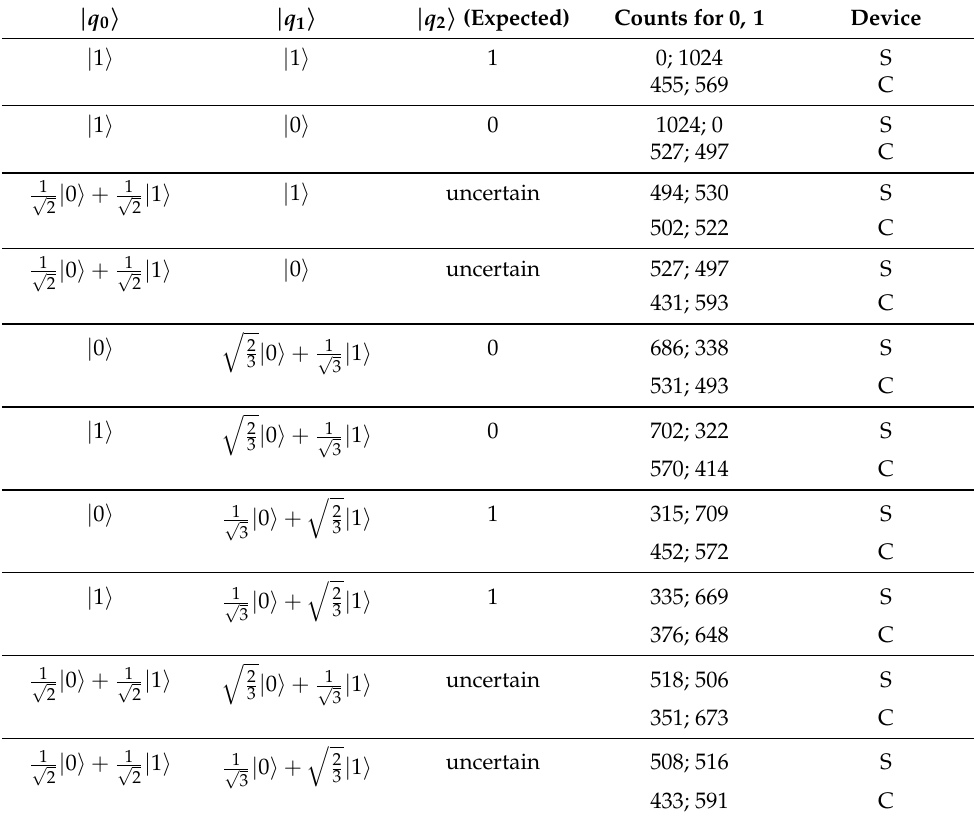
Table 2. Comparisons of measurement outcomes for 1024 shots of the code. S indicates the simulator; C stands for a real quantum computer located in Bogotà,